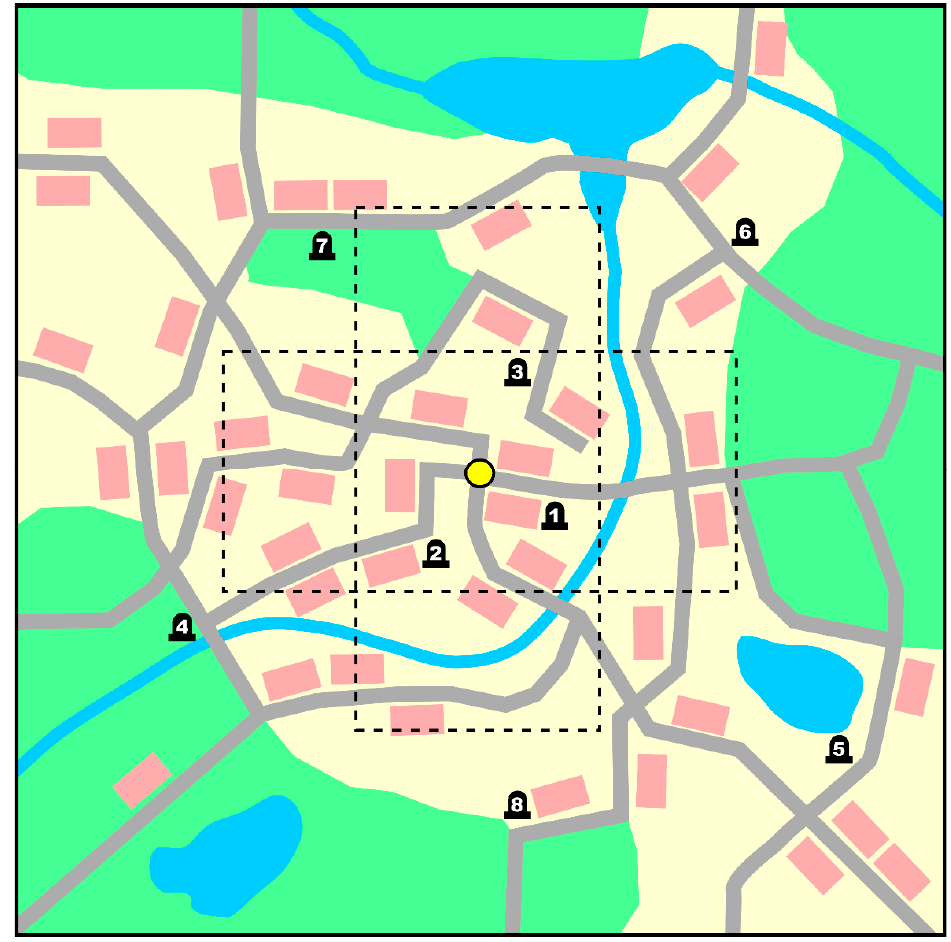
Figure 2. Simplified content of the designed topographic map with initial view frames in landscape and portrait orientations.